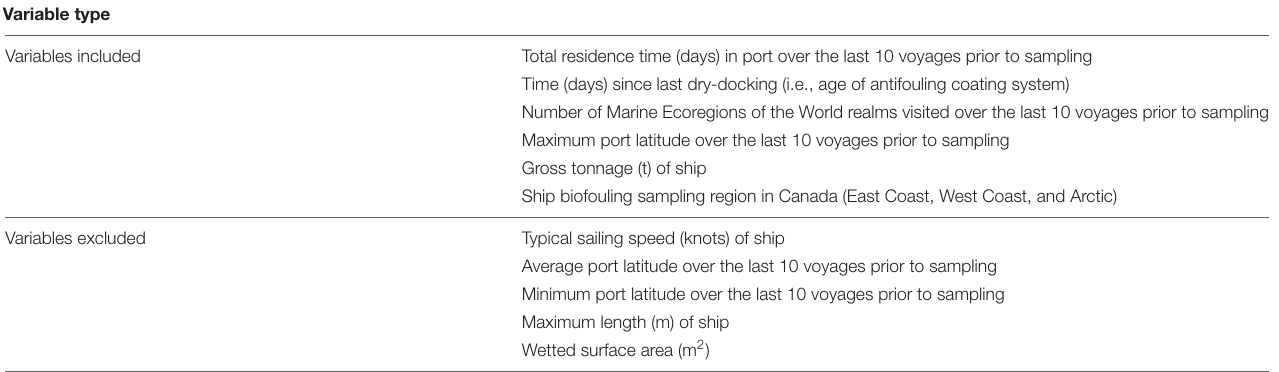
TABLE 1 | Variables assessed in the regression tree analyses to develop tree-based models for predicting biofouling extent on ships. Variable